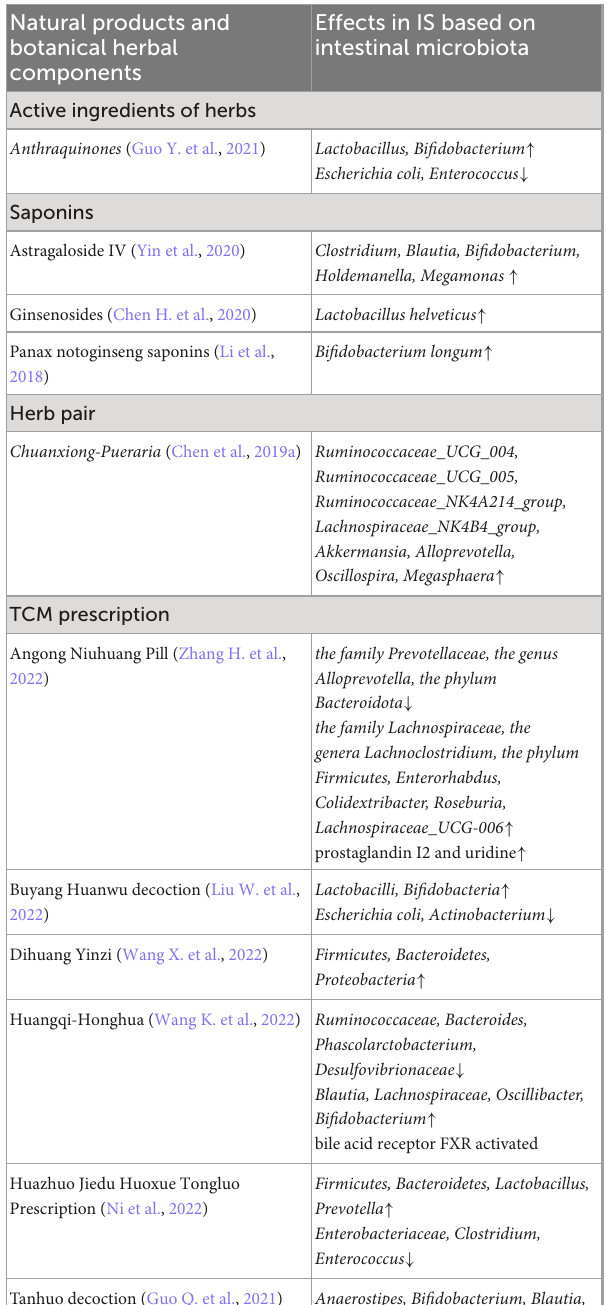
TABLE 1 The summary of pharmacological effects of herbal ingredients and natural products in IS based on the intestinal